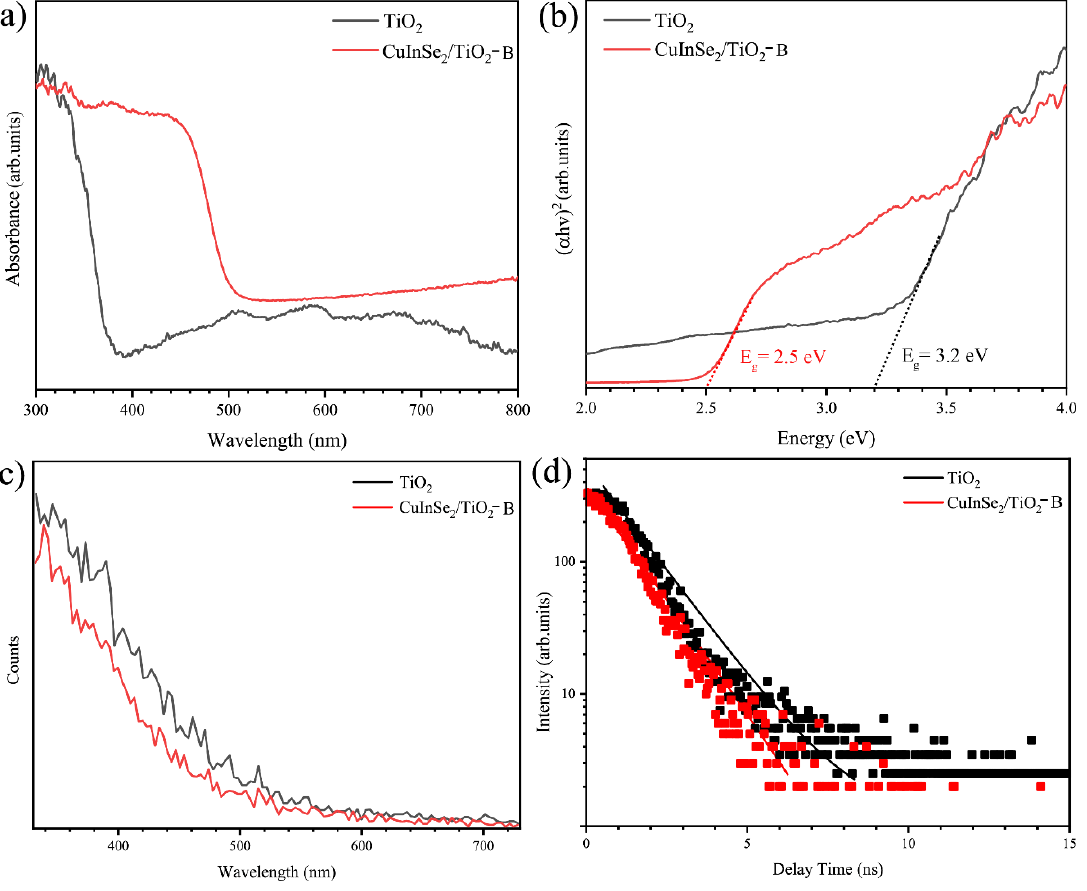
Figure 5. ( a ) UV ‐ vis DRS, ( b ) Tauc plots, ( c ) PL spectra and ( d ) time ‐ resolved PL spectra of the pre ‐ Figure 5. ( a ) UV-vis DRS, ( b ) Tauc plots, ( c ) PL spectra and ( d ) time-resolved PL spectra of pared TiO 2 and CuInSe 2 /TiO 2 ‐ B. Table 1. Fitting results from Figure 5d .